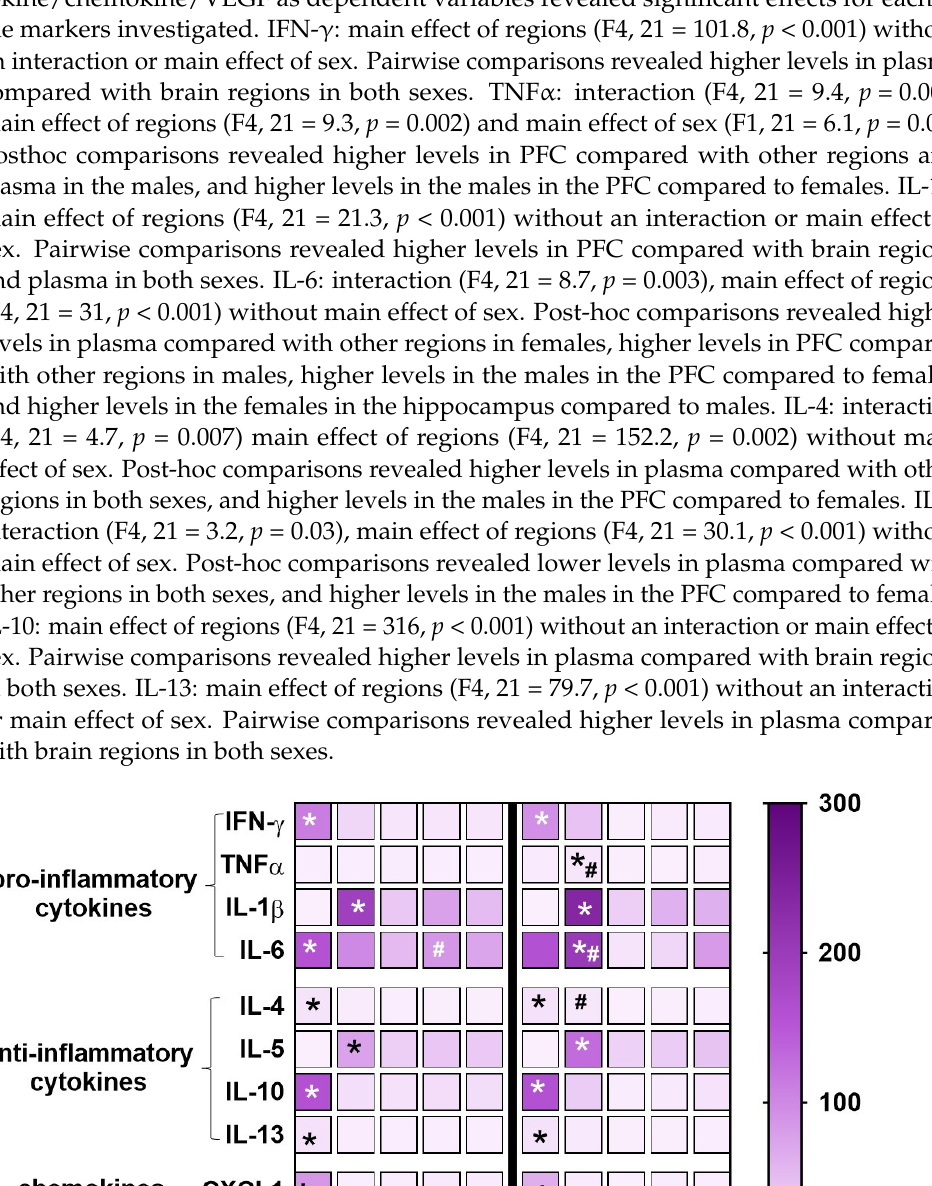
of sex (F1, 21 = 9.2, p = 0.006). Post-hoc comparisons revealed higher levels in PFC com- pared with other regions and plasma in the males, and higher levels in the males in the PFC compared to females. 3.3. LPS Enhances Peripheral Levels of Cytokines: Sex Specific Effects We determined the effects of LPS on inflammatory cytokines and VEGF in plasma isolated from male and female rats (Figure 3). Two-way ANOVA was performed with sex and LPS as independent variables, and markers as the dependent variable. We report sta- tistical analysis for each marker. TNF α : main effect of LPS (F1, 12 = 26.02, p = 0.003) with- out an interaction or main effect of sex. Pairwise comparisons revealed higher levels after LPS treatment in females compared to saline condition. IL-1 β : main effect of LPS (F1, 12 = 10.5, p = 0.007) without an interaction or main effect of sex. Pairwise comparisons did not detect any differences. IL-6: main effect of LPS (F1, 12 = 23.5, p = 0.004) without an inter- action or main effect of sex. Pairwise comparisons revealed higher levels after LPS treat- ment in males compared to saline condition. IL-13: main effect of LPS (F1, 12 = 12.32, p = 0.004) without an interaction or main effect of sex. Pairwise comparisons revealed higher levels after LPS treatment in females compared to saline condition. CXCL1: main effect of